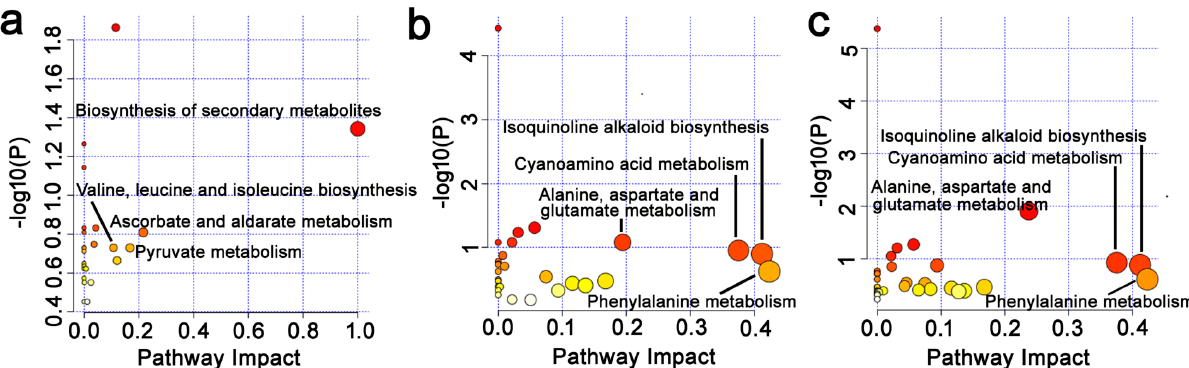
Figure 8. The enrichment analysis of metabolic pathway in leaves. The metabolic pathways of a, b, and c mean between LE+ and LE − at 0.01 mM P (0.01 mM LE+ vs. LE − ) ( a ); between 0.01 and 0.5 mM P in LE+ (LE+ 0.01 mM vs. 0.5 mM) ( b ); between 0.01 and 0.5 mM P in LE − (LE − 0.01 mM vs. 0.5 mM) ( c ), respectively.